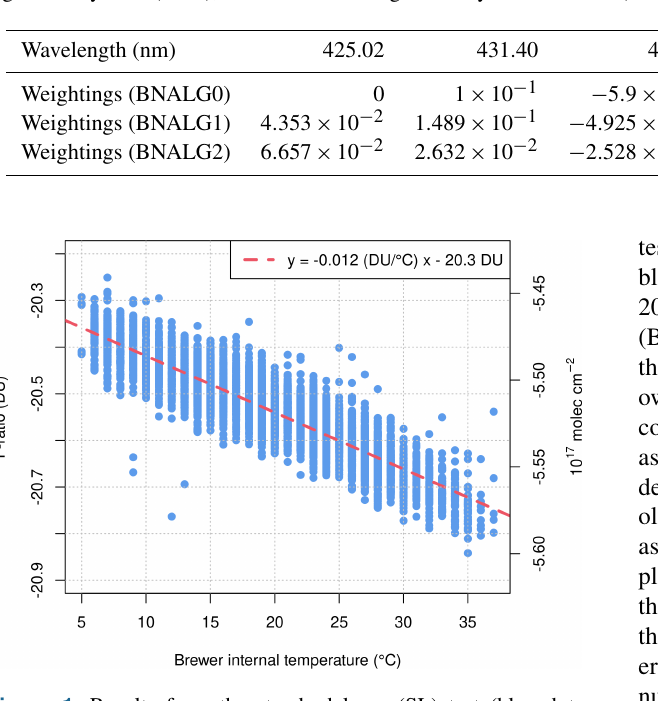
Table 1. Operating wavelengths and weightings ( γ i ) employed with Brewer #067 for the retrieval of nitrogen dioxide. BNALG0 refers to the algorithm by Kerr (1989), BNALG1 to the algorithm by Diémoz et al. (2014b), and BNALG2 to the updates proposed in this paper.